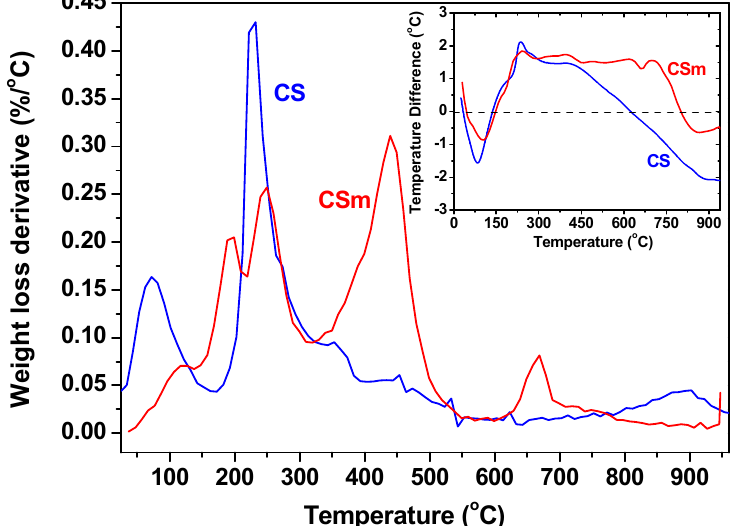
Figure 5. Differential thermogravimetry (DTG) curves in nitrogen (inset: differential thermal analysis (DTA) curves in